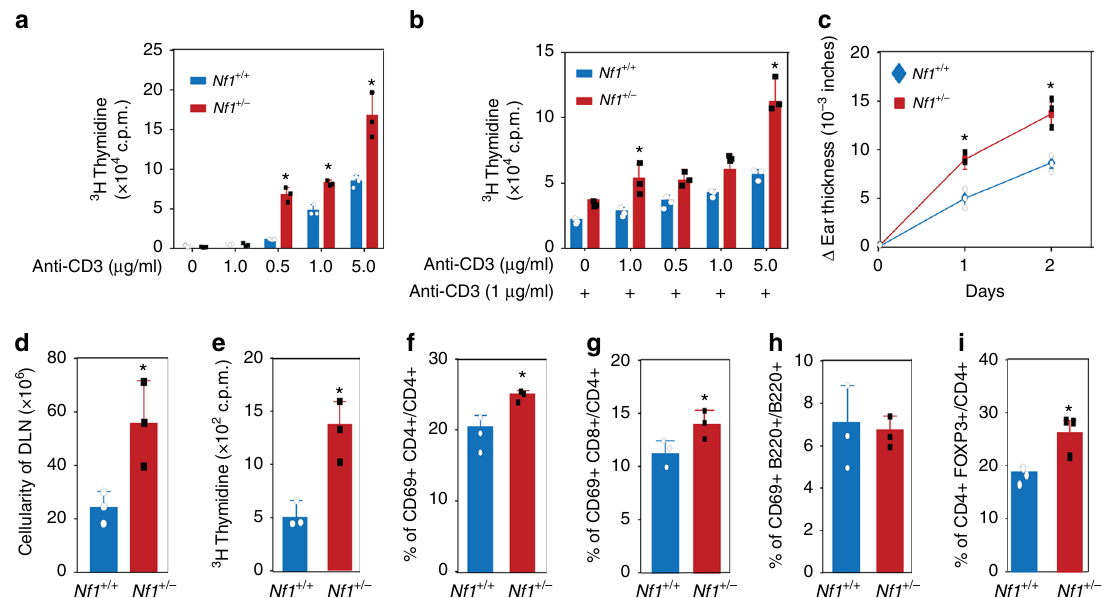
Fig. 6 Impact of Nf1 heterozygosity on T cells proliferation and function. a , b Proliferation of peripheral T cells from Nf1 + / + and Nf1 + / − mice stimulated by various concentrations of a anti-CD3e antibody alone or with b CD28 costimulation. Proliferation was assessed in biological duplicate and technical triplicate by 3 H-thymidine incorporation during the last 20 h of culture. c Delayed-type hypersensitivity (DTH) assay: On day 0, Nf1 + / + and Nf1 + / − mice were sensitized on abdominal skin by topical application of oxazolone. On day 6, Nf1 + / + and Nf1 + / − mice were challenged by topical application on the left and right ear with oxazolone and control solvent, respectively. DTH was assessed daily through by measuring ear thickness ( Δ ). Experiments were performed in biological triplicates. d Two days after challenge, cellularity of draining lymph nodes (DLNs) of Nf1 + / + and Nf1 + / − mice were determined. e Spontaneous activation of cells from DLNs (T cells) was measured by 3 H-thymidine incorporation after culturing for 3 days without stimuli. f Fraction of CD4 + cells that are activated. g Fraction of CD8 + cells that are activated. h Fraction of B cells + that are activated. i Fraction of Treg + cells in total CD4 + subset. Panels d – i were performed in biological triplicates. Statistical paired t -test performed; * P < 0.05. Variation was estimated using standard deviation